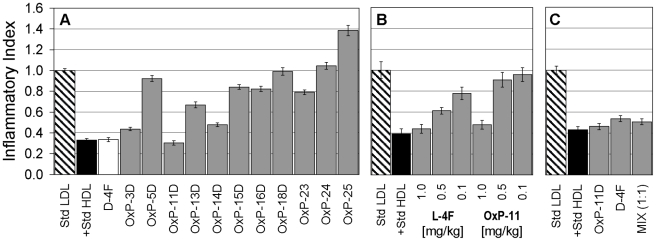

In vivo activity of selected OxP peptides.Panel A: Fasting female apoE deficient mice received 1.0 mg/kg of OxP peptides subcutaneously in 200 µL of ABCT buffer. After 6 hours of additional fasting, blood was obtained and HDL was isolated and tested in the monocyte chemotaxis assay as described in Methods. Results were normalized to LDL and are expressed as Inflammatory Indices. An index below 1.0 indicates anti-inflammatory activity in this test. Panel B compares L-4F and OxP-11 both containing L-amino acids exclusively. Both peptides were injected subcutaneously at three different amounts, 1.0, 0.5 and 0.1 mg/kg. Panel C compares the in vivo activity of D-4F, OxP-11D and a 1∶1 mixture (by weight), all administered at 1 mg/kg. D-4F and OxP-11D were equally effective alone and in combination.